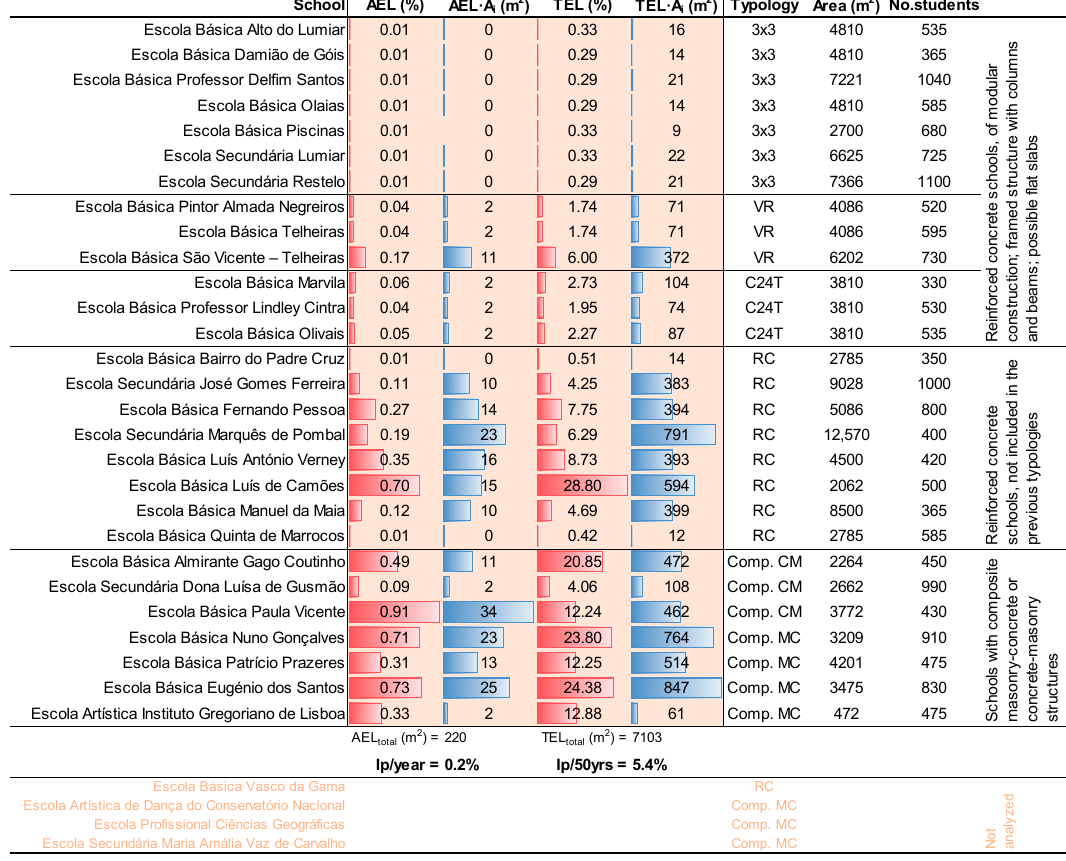
Figure 12. School ranking according to expected losses over 50 years (as a percentage of school ar- ea).